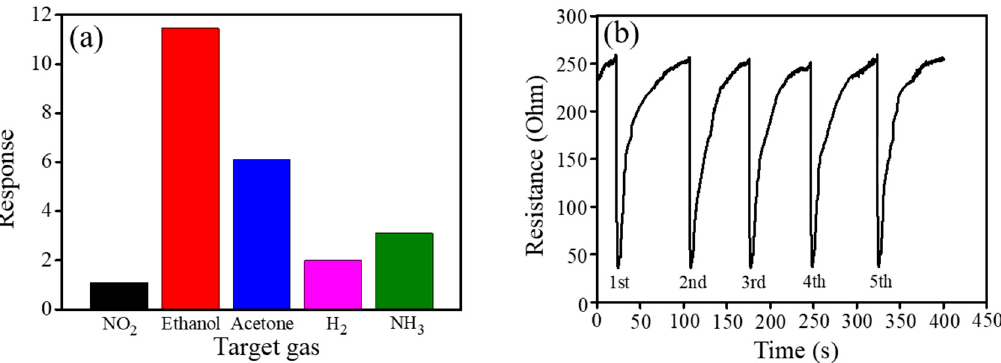
Figure 7. ( a ) The cross gas-sensing sensitivity of the ZnO-NiO-1 sensor towards various target gases. ( b ) Cyclic ethanol vapor-sensing curves for the ZnO-NiO-1 sensor towards 100 ppm ethanol vapor.